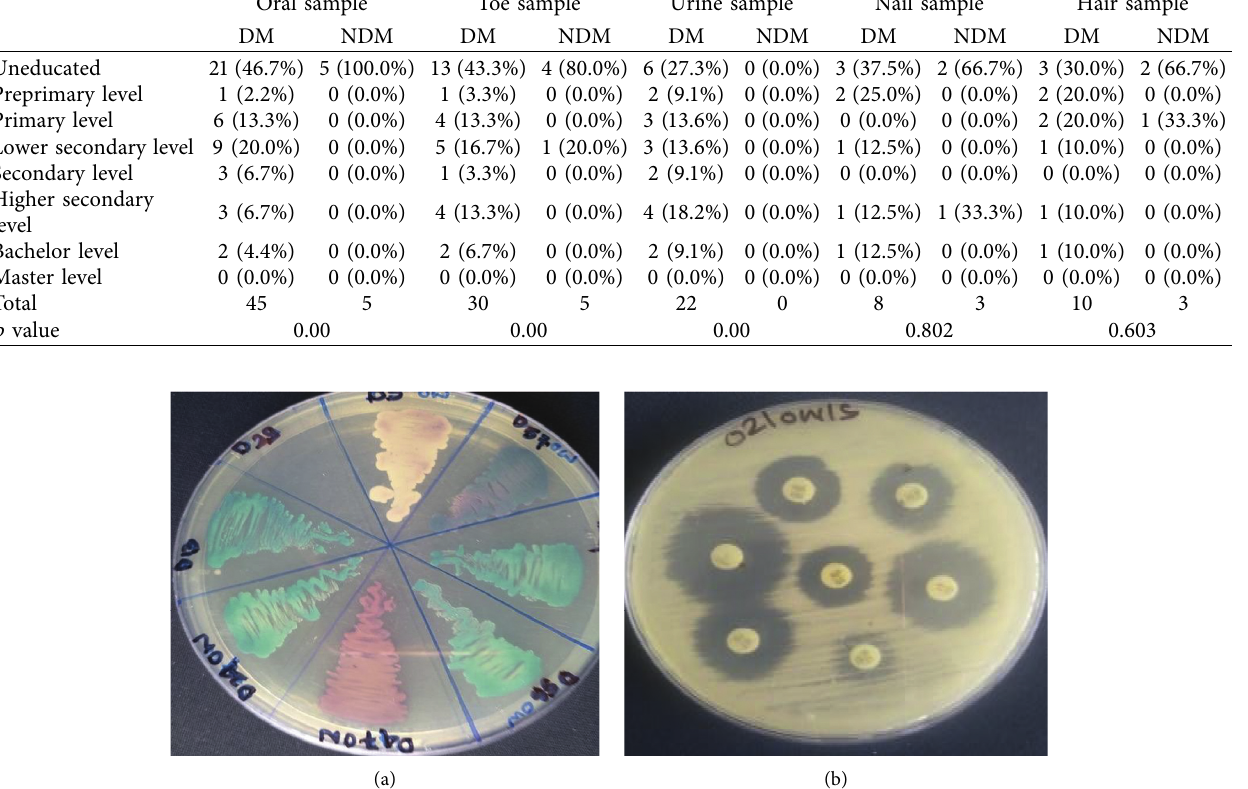
Table 3: Relation between education levels and the prevalence of fungi in diabetic and nondiabetic groups. Oral sample Toe sample Urine sample Nail sample Hair sample